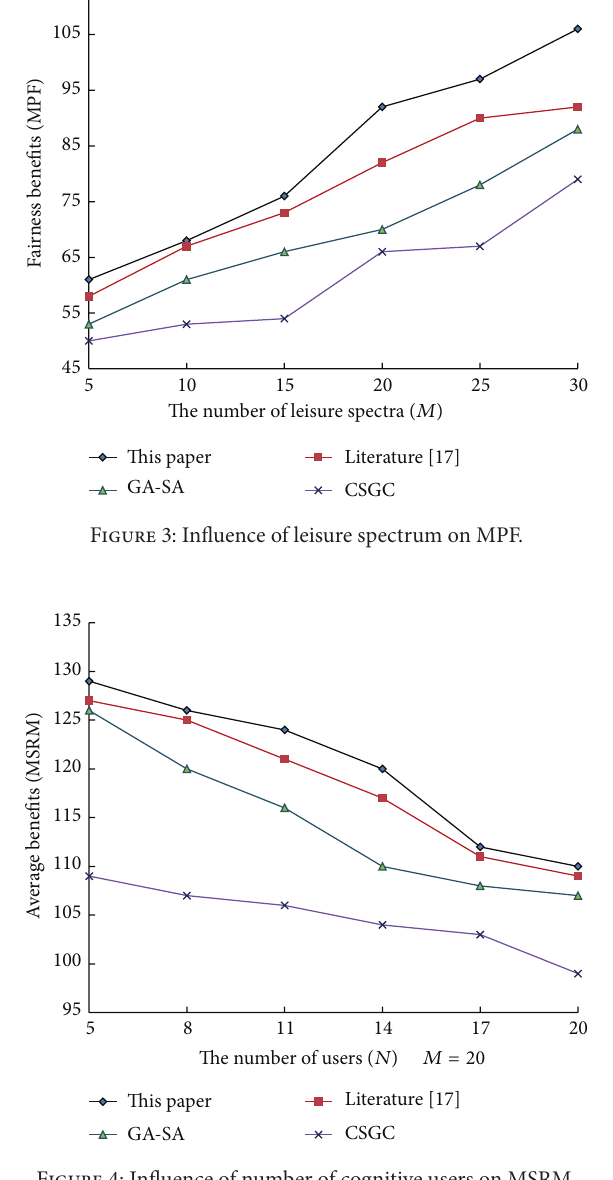
Figure 6: Influence of number of cognitive users on